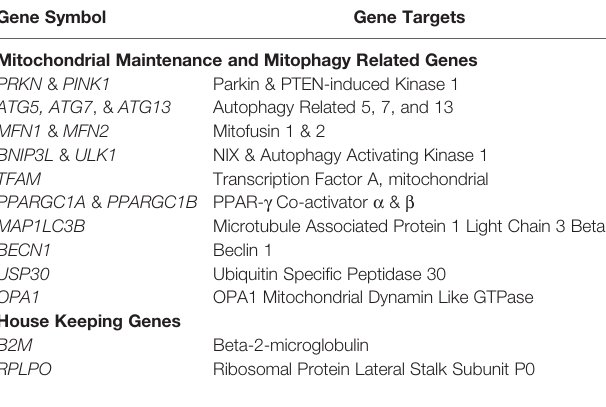
TABLE 1 | List of gene targets analyzed by RT 2 qPCR pro fi ler arrays. Gene